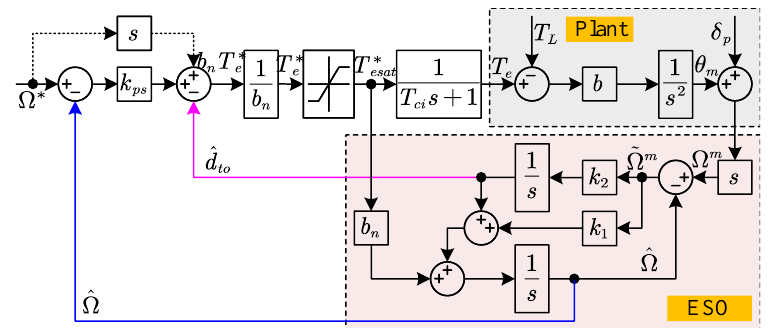
Figure 1. Block diagram of the conventional ESO-ADRC